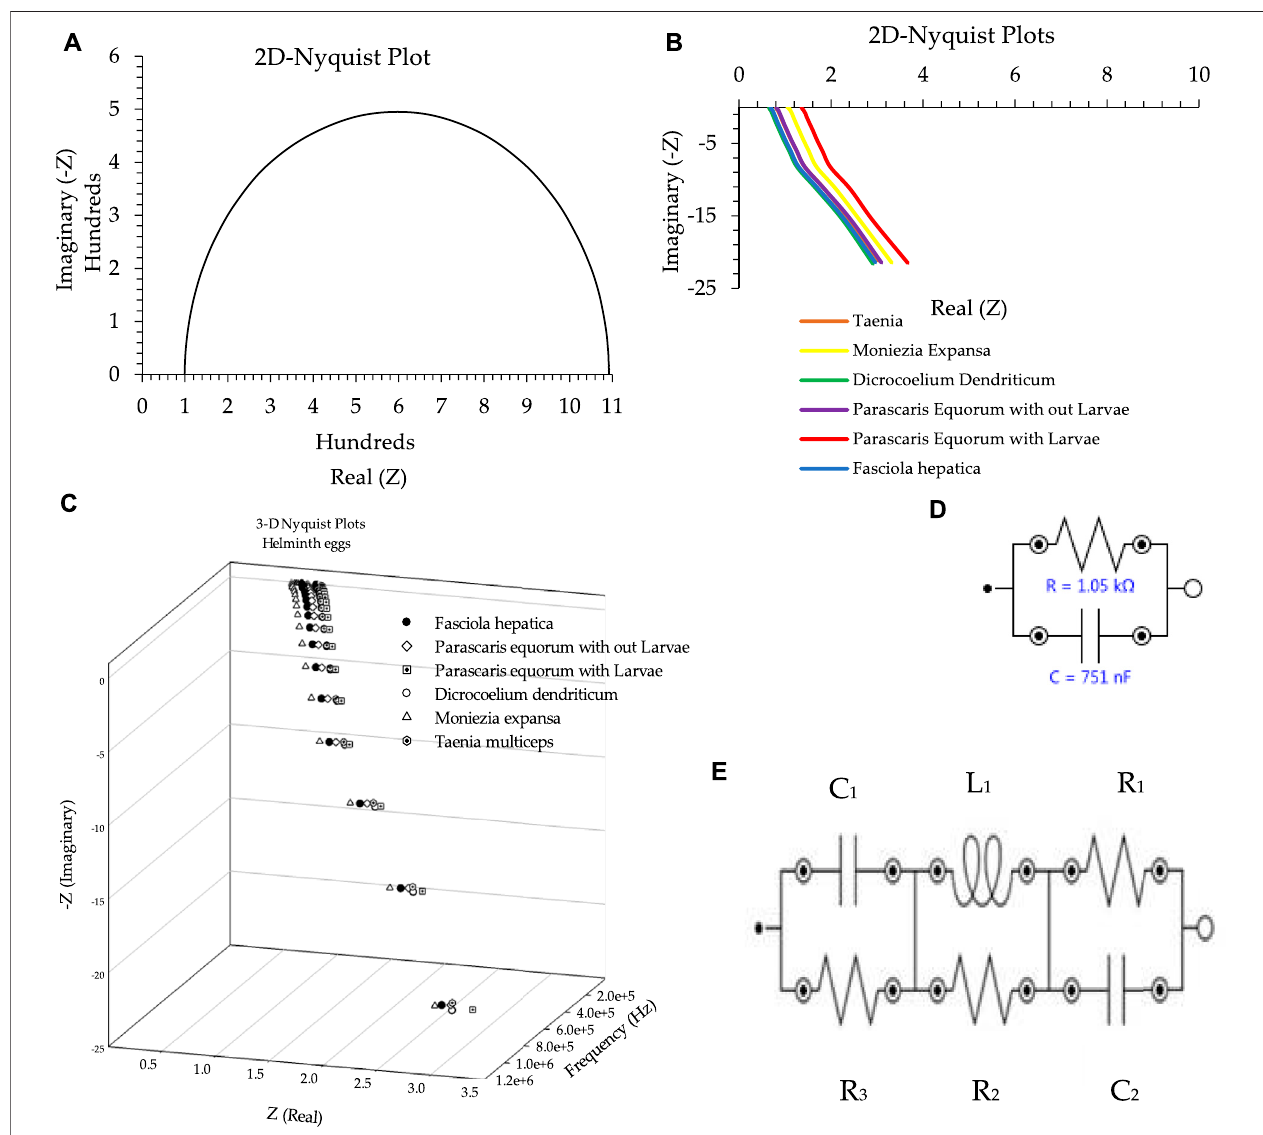
FIGURE1|(A) Nyquistplotintheabsenceofthehelminthegg. (B) Two-dimensionalNyquistplotforalltypesofhelmintheggs. (C) Three-dimensionalNyquistplot asasampleofalltypesofhelmintheggs. (D) Equivalentcircuitasanexamplefortheabsenceofanyhelminthegg. (E) Equivalentcircuitasanexampleforthepresenceof all types of helminth eggs. Conditions: All conditions and procedures are expressed in detail as mentioned above during implanting two microelectrodes with 0.0124 ± 0.0008 mm inter-electrode distance, error bar: ± standard deviation ( n (cid:2) 5).